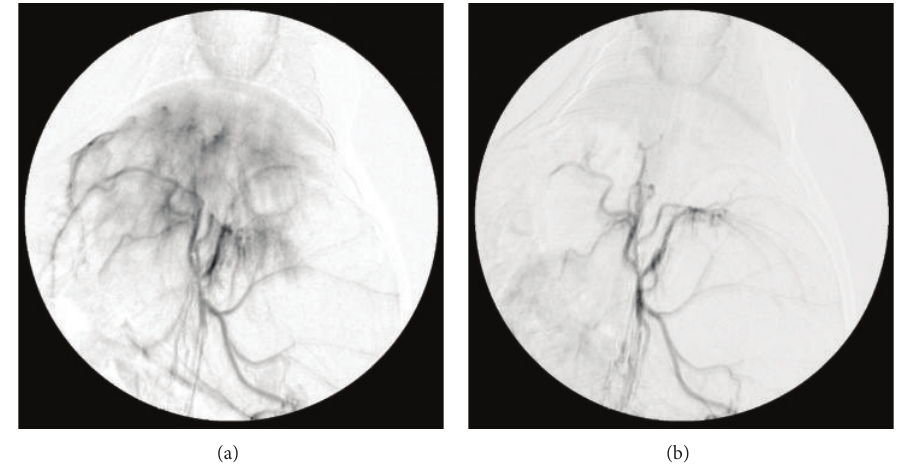
Figure 5: Angiograms of rabbit liver obtained before (a) and after (b) embolization by cross-linked BSA beads.